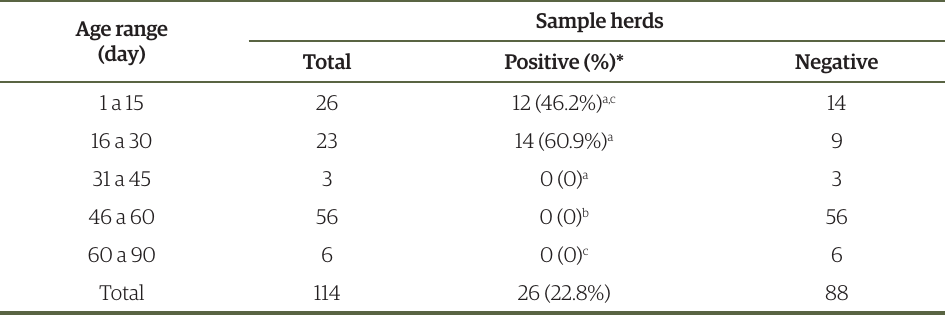
Table 4. Positive results in rotavirus PAGE, according to age of calves, in beef cattle from the north of the State of São Paulo, from 2006 to 2010.